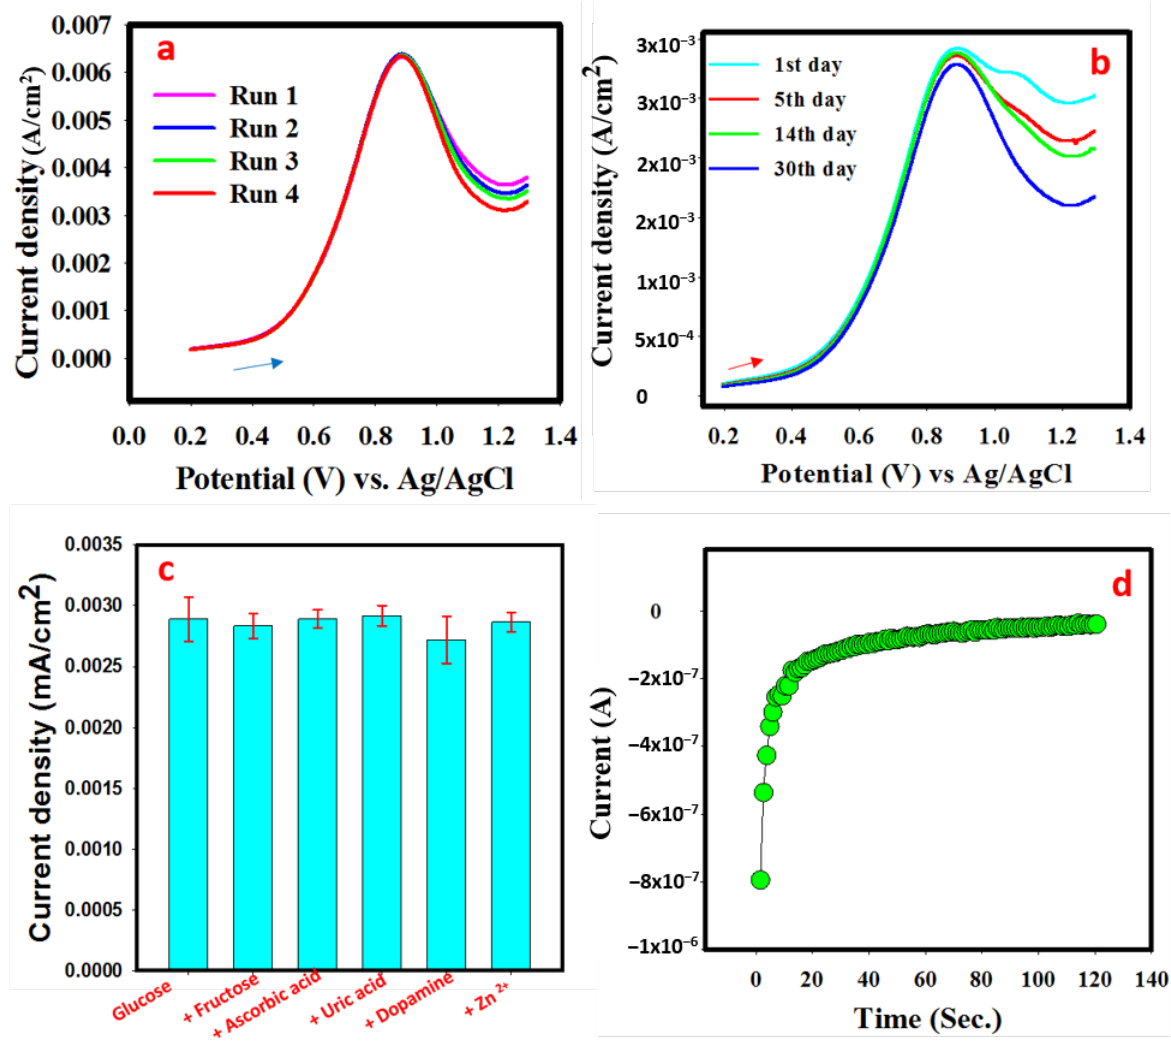
Figure 7. ( a ) Current density response of PANI-MnBaO 2 in 4 mM glucose performed at five consecu- tive times. ( b ) LSV response of PANI-MnBaO 2 in 2 mM glucose obtained over a period of 30 days. ( c ) Peak current density in 2 mM glucose (with and without likely interferents). ( d ) the obtained response time in 2 mM glucose